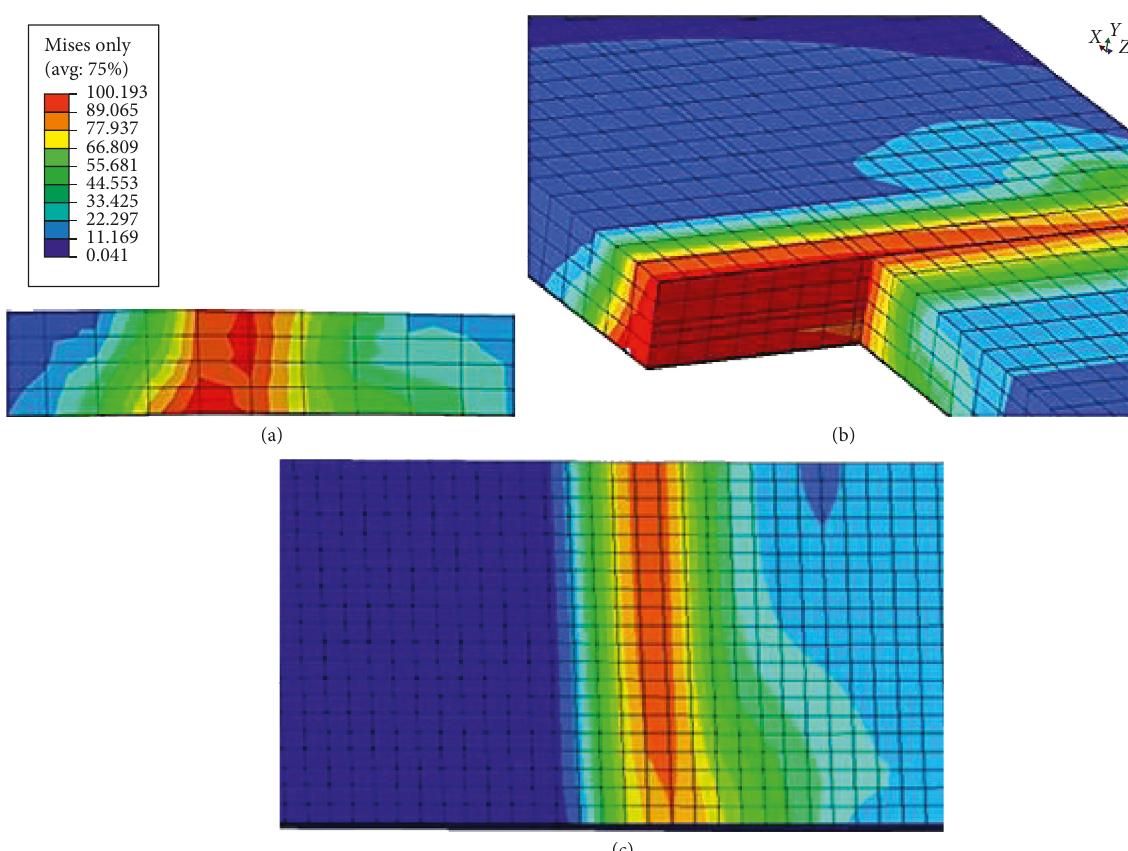
Figure 12: The distribution of equivalent stresses in the thermal deformation hearth (a, b) and in the zone of contact of the tape with the surface of the part (c) in the case of electrocontact surfacing with a steel tape at K v